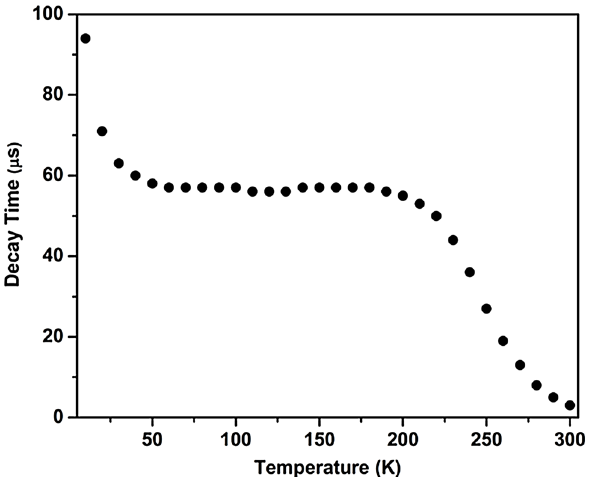
Fig. 6 Decay constants of a NWO crystal as a function of temperature